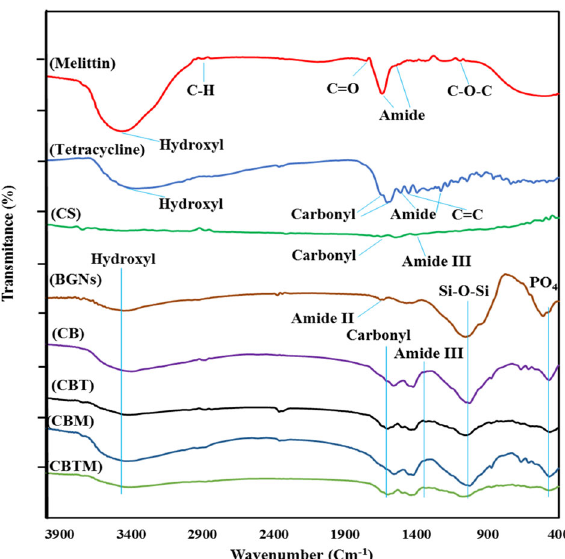
Fig. 3 FTIR spectra of pristine components and composite coatings